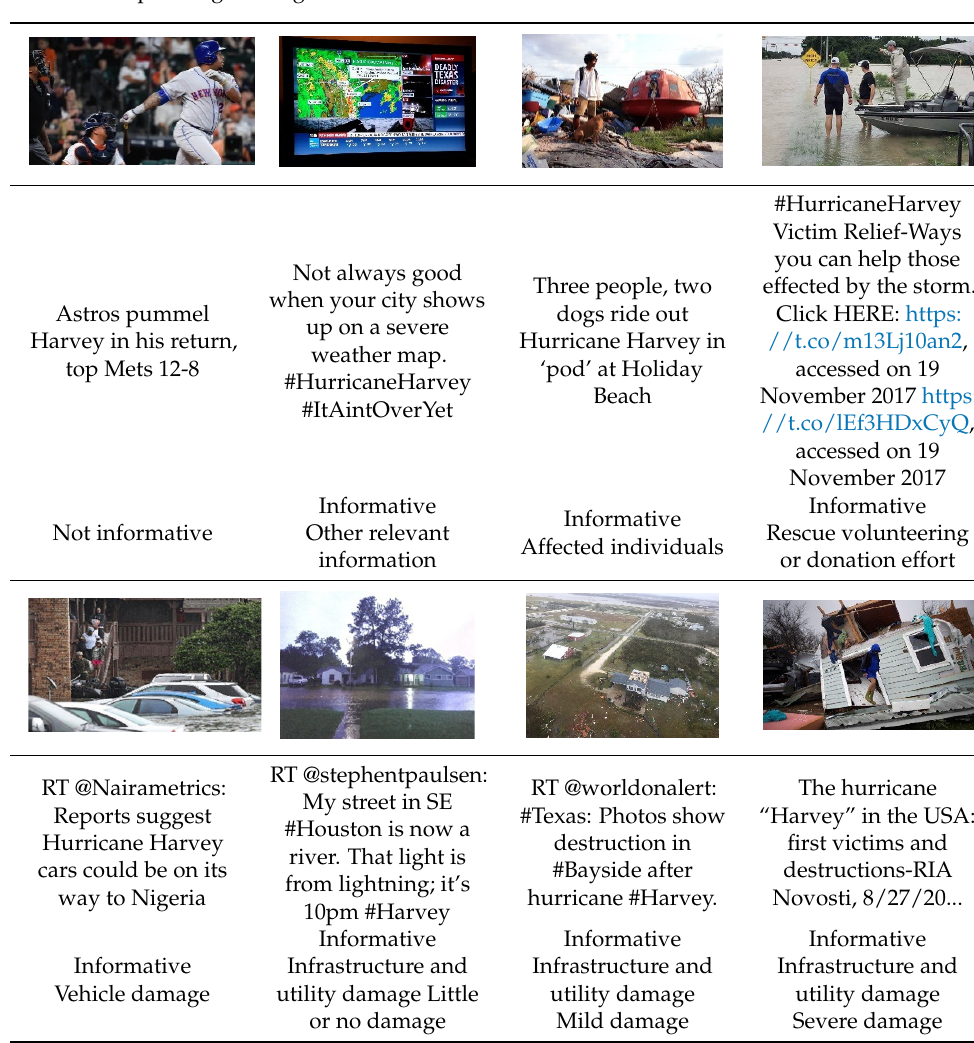
Table 5. Sample images along with their text and annotations.